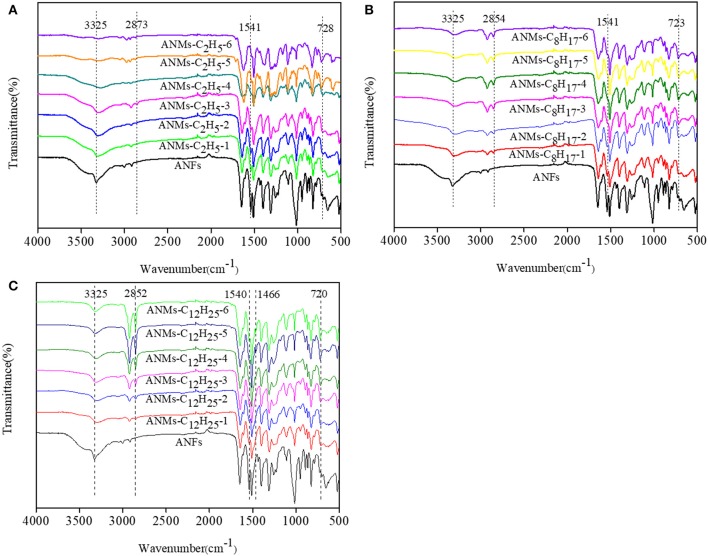
IR spectra of (A) ANFs, and ANMs-C2H5-X, (B) ANFs, and ANMs-C8H17-X, (C) ANFs, and ANMs-C12H25-X.